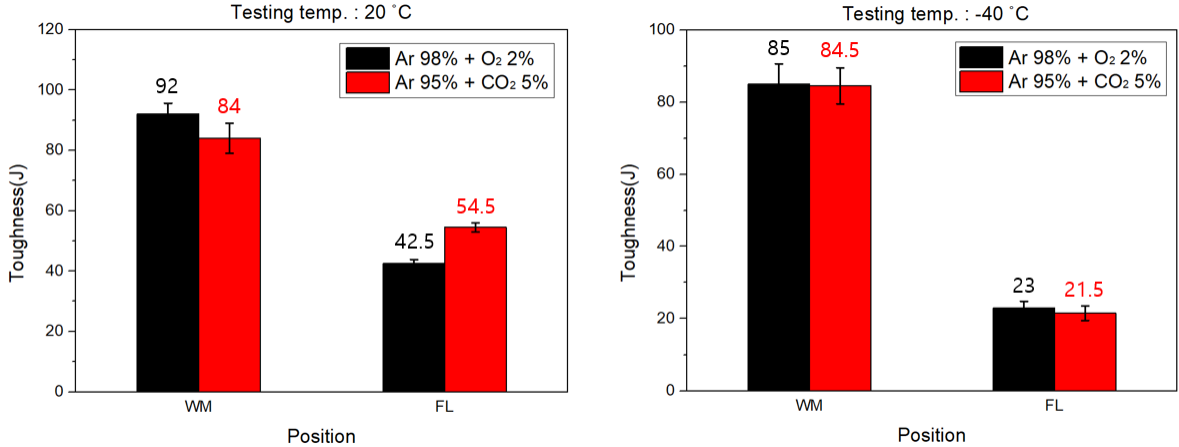
Figure 4. Toughness results of HHA1 butt joints at room temperature (20 °C) and low temperature ( − 40 °C).